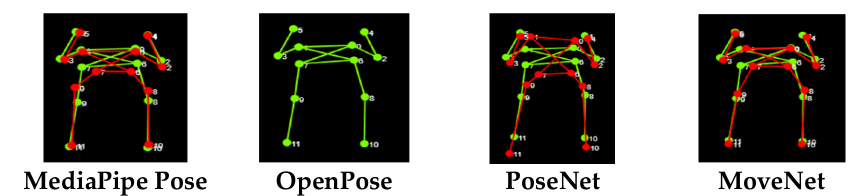
Figure 7. Sample video frame and detection result of Action 2 (bench press). Green lines indicate the ground truth, red lines indicate the tested HPE library.